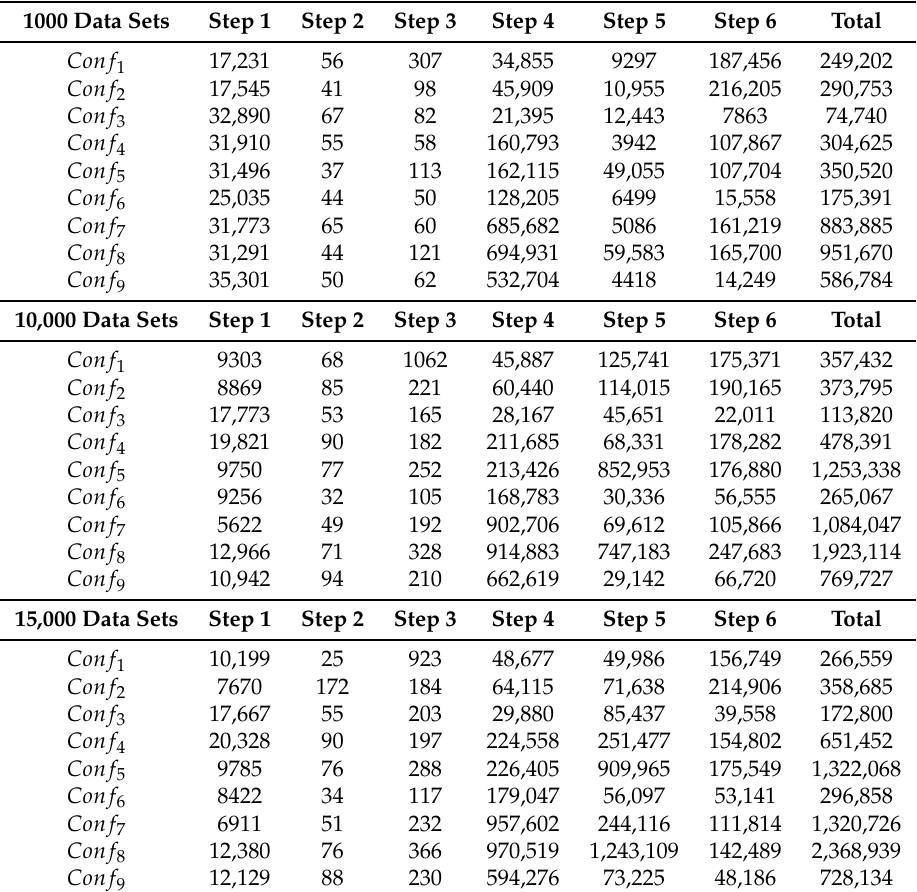
Table 8. Execution times for the corpus of 1000–10,000–15,000 data sets for version Spark V2 . 1000 Data